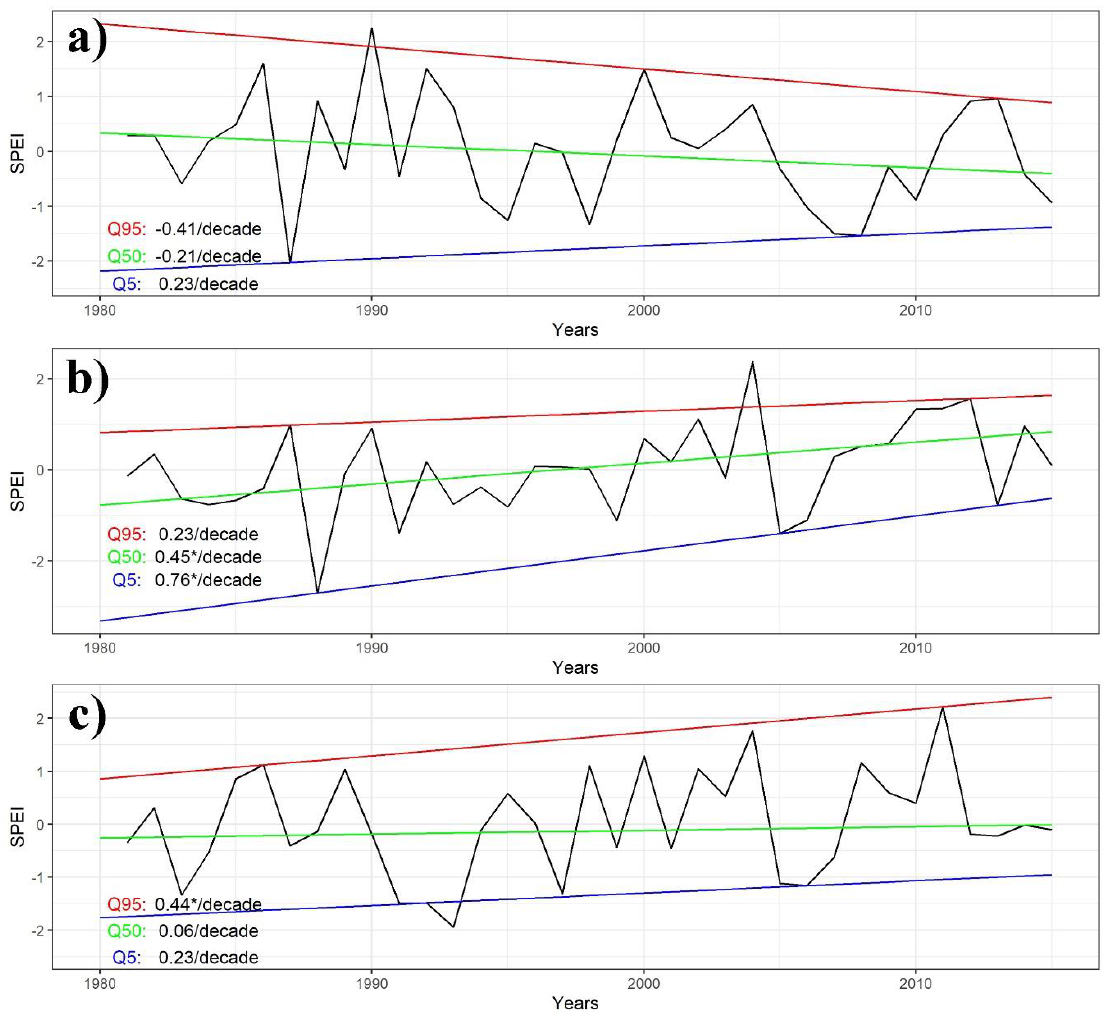
Figure 3. Trends of SPEI-3/decade multi quantile levels for the NDJ quarter in the cities ( a ) Barreiras (BA), ( b ) João Pessoa (PB), and ( c ) Fortaleza (CE). * Confidence interval used: 95%.